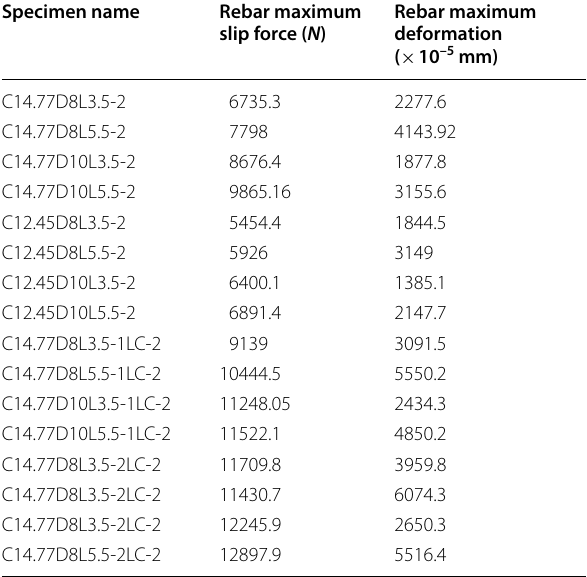
Table 9 Maximum force and rebar deformation in different